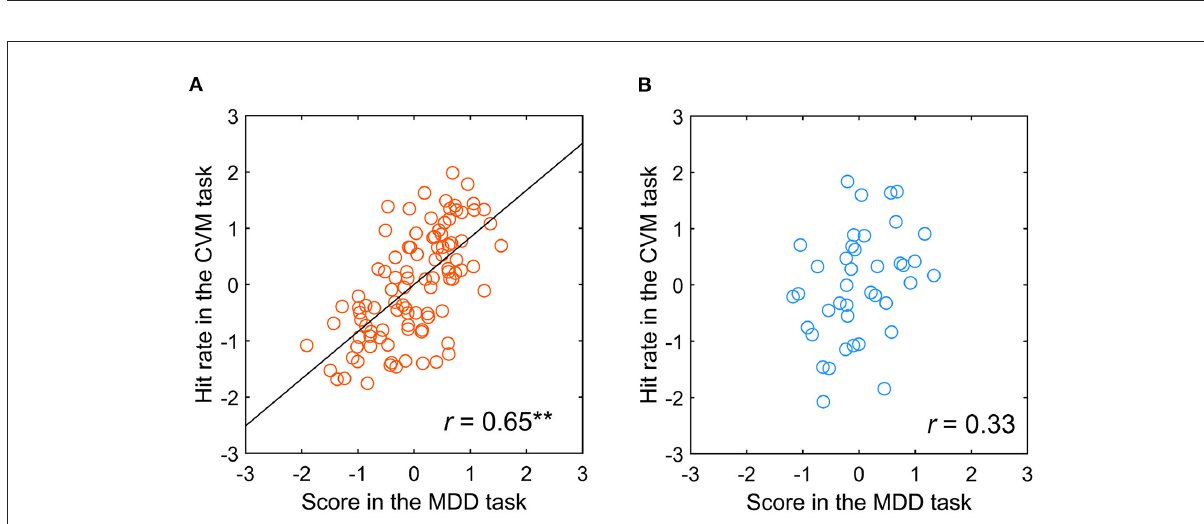
left, 13.1%; both 11.0%) or reaction time (right, 0.2s; left, 0.2s; both,